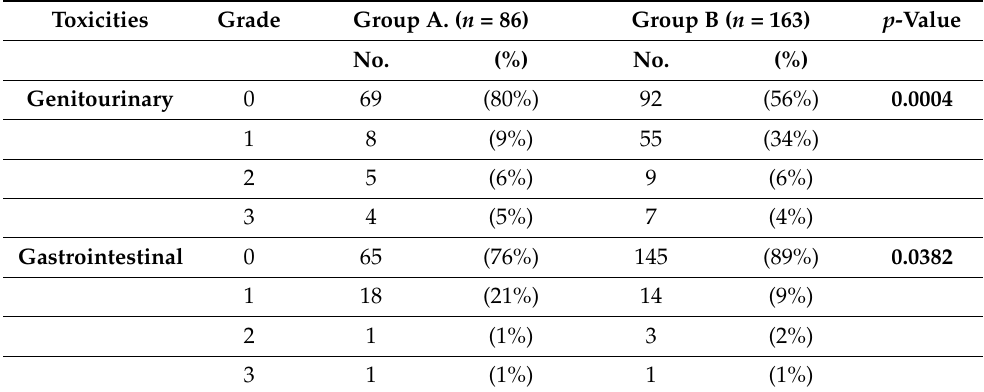
Table 5. Late toxicity between Group A and